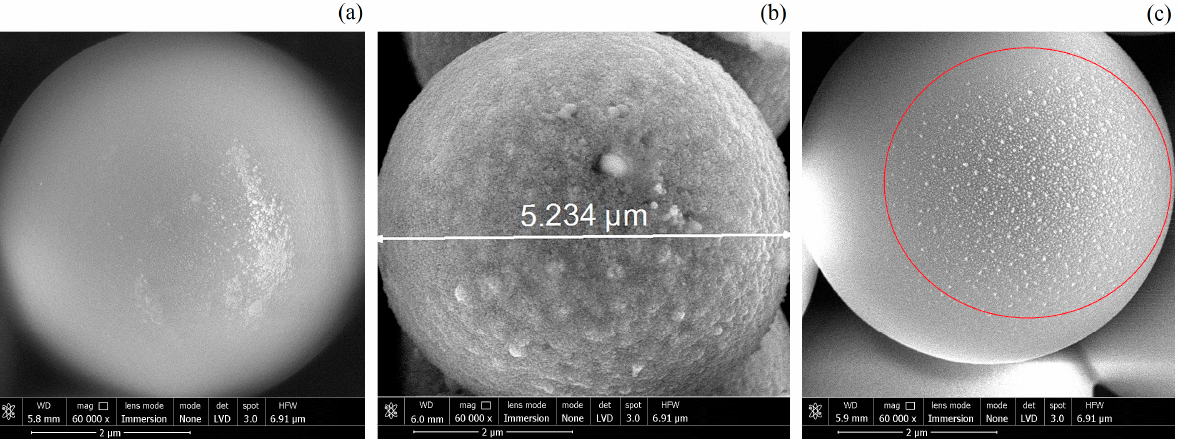
Figure 1. SEM photographs of the spherical melamine-formaldehyde (MF) dust particles with a diameter of 5 µm: ( a ) uncoated; ( b ) Cu-coated; ( c ) Janus particle.